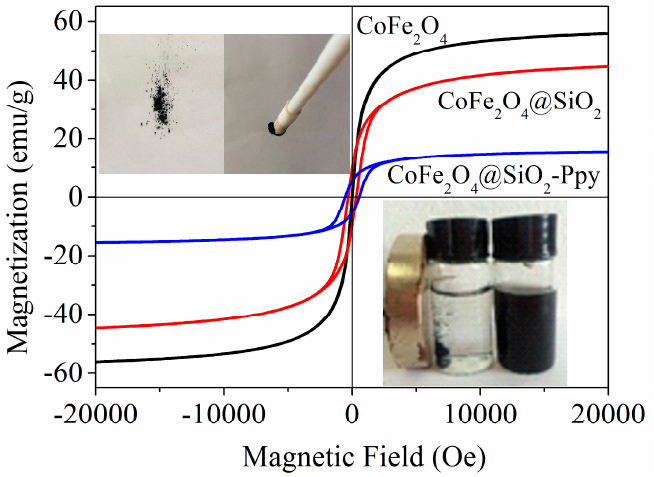
Figure 7. Vibrating sample magnetometry (VSM) analysis of the three as-prepared materials.